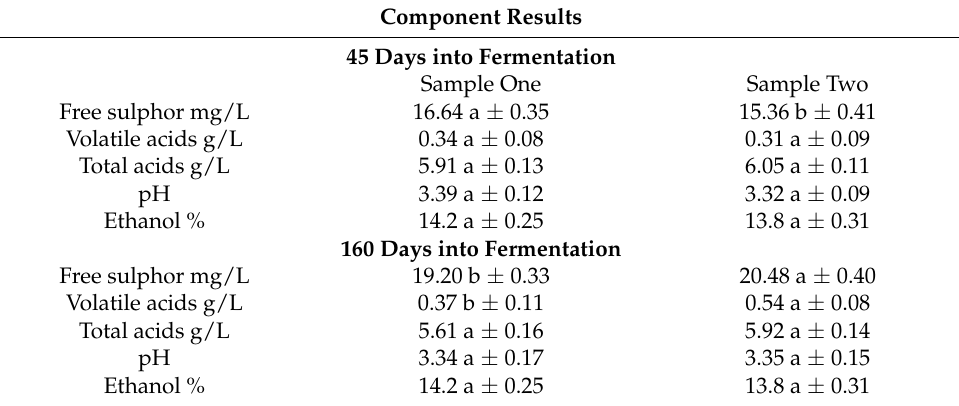
Table 3. Basic physical–chemical content of fermenting wine.